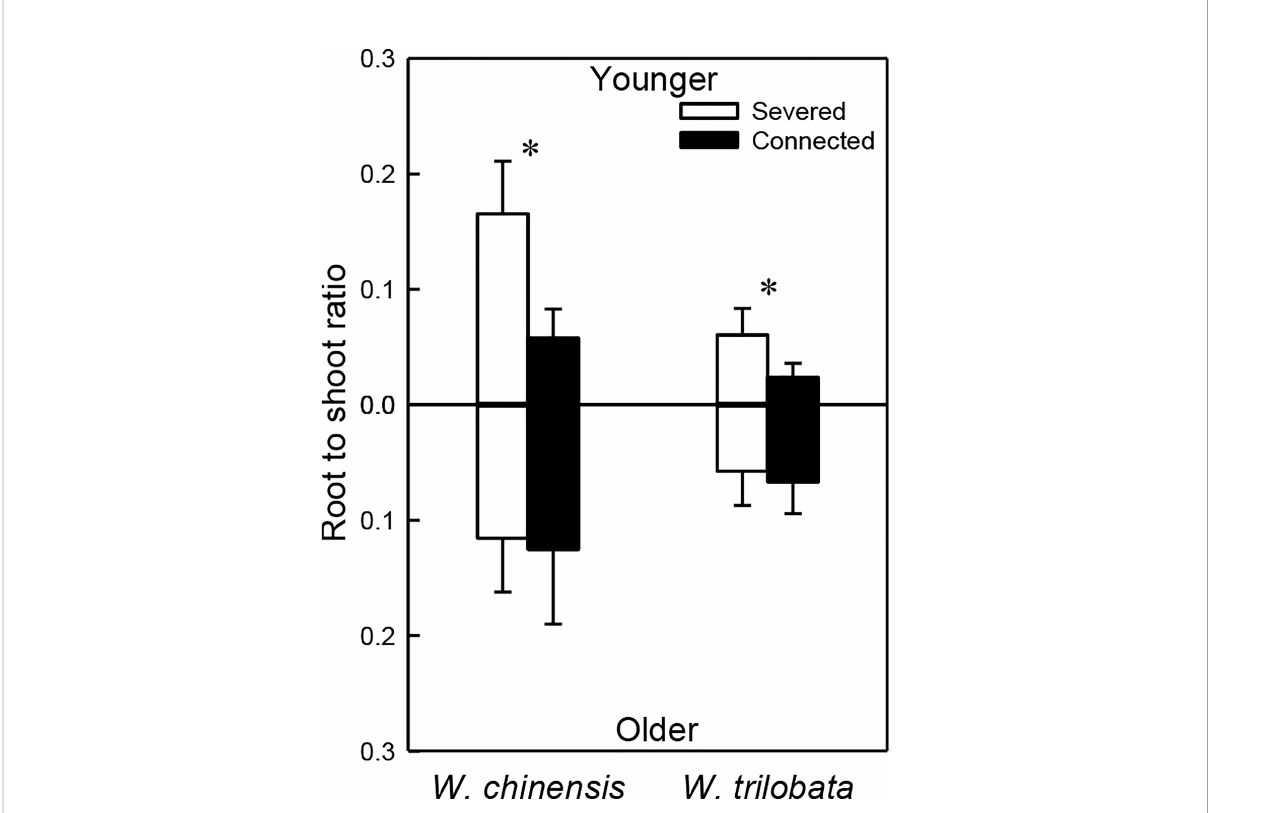
FIGURE 4 Root shoot ratio of the younger ramet (above the x-axis) and the older ramet (below the x-axis) of the invasive plant Wedelia trilobata and the native plant W. chinensis . Values are means ± SE. Symbols (* P < 0.05) indicate the signi fi cant differences between the severed ramets and connected ramets within a